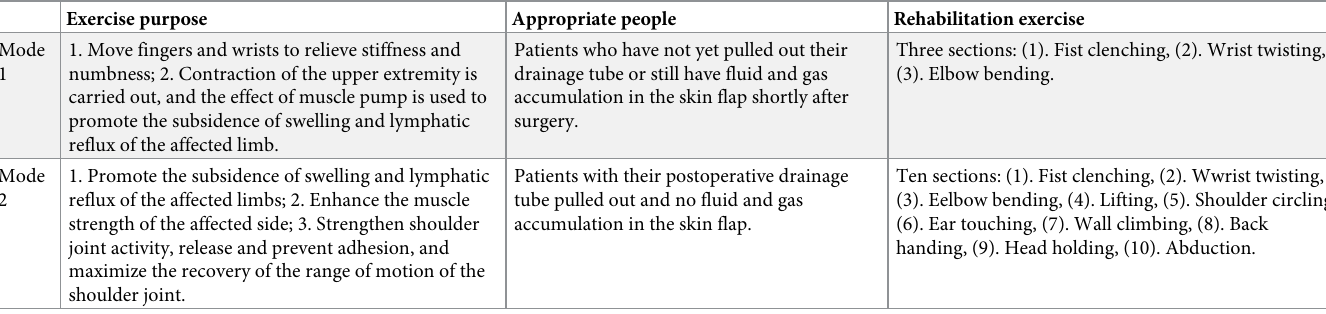
Table 1. Exercise model. 1. Move fingers and wrists to relieve stiffness and numbness; 2. Contraction of the upper extremity is carried out, and the effect of muscle pump is used to promote the subsidence of swelling and lymphatic reflux of the affected limb. 1. Promote the subsidence of swelling and lymphatic reflux of the affected limbs; 2. Enhance the muscle strength of the affected side; 3. Strengthen shoulder joint activity, release and prevent adhesion, and maximize the recovery of the range of motion of the shoulder joint.